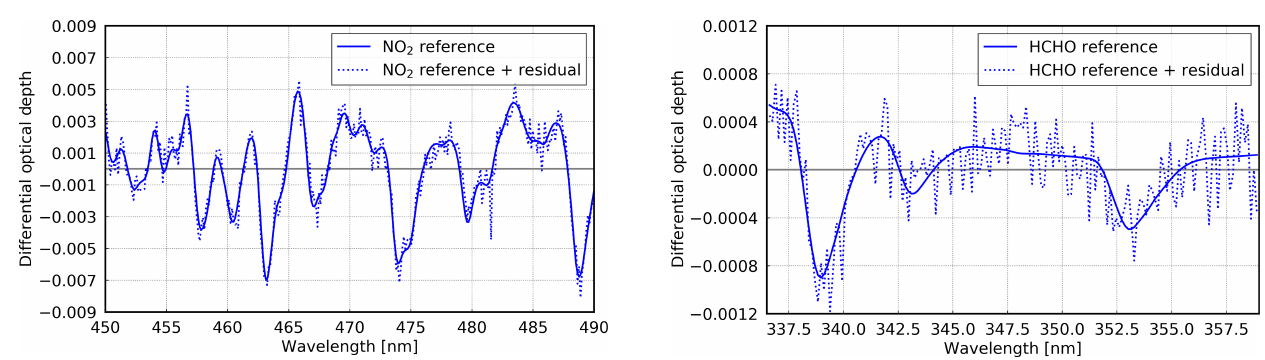
Figure 4. Example of a stratospheric NO 2 fit for 14 October 2016 at 06:58UTC (latitude: ∼ 7.4 ◦ N; longitude: ∼ 17.8 ◦ W). Both are shown, the reference scaled with the SCD as well as the scaled ref- erence plus the residual. Zenith sky measurement with a SCD of 3.99 × 10 16 moleccm − 2 and a rms of 6.9 × 10 − 4 at 90.9 ◦ SZA.